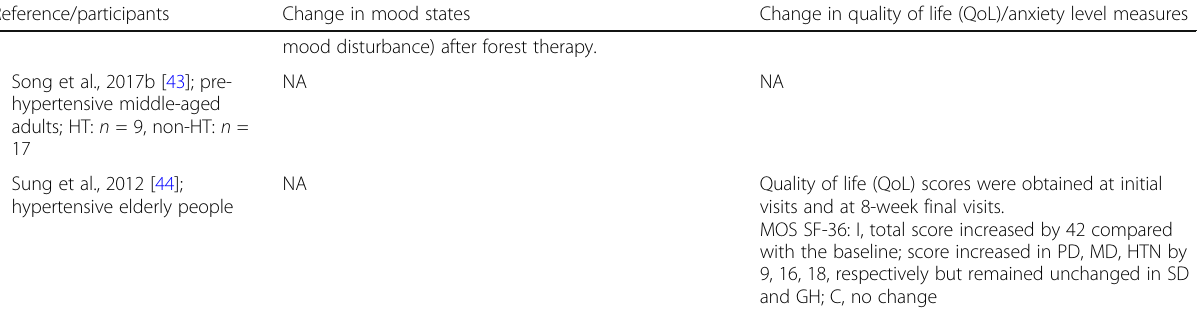
Table 3 Summary of outcomes measures on psychological response of the included studies (Continued) Reference/participants Change in mood states Change in quality of life (QoL)/anxiety level measures mood disturbance) after forest